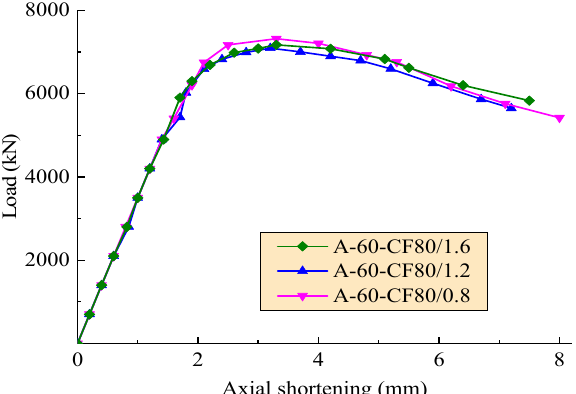
Materials 2019 , 12 , x FOR PEER REVIEW Figure 7. Axial load-deformation curves with a varying volume fraction of steel fiber.